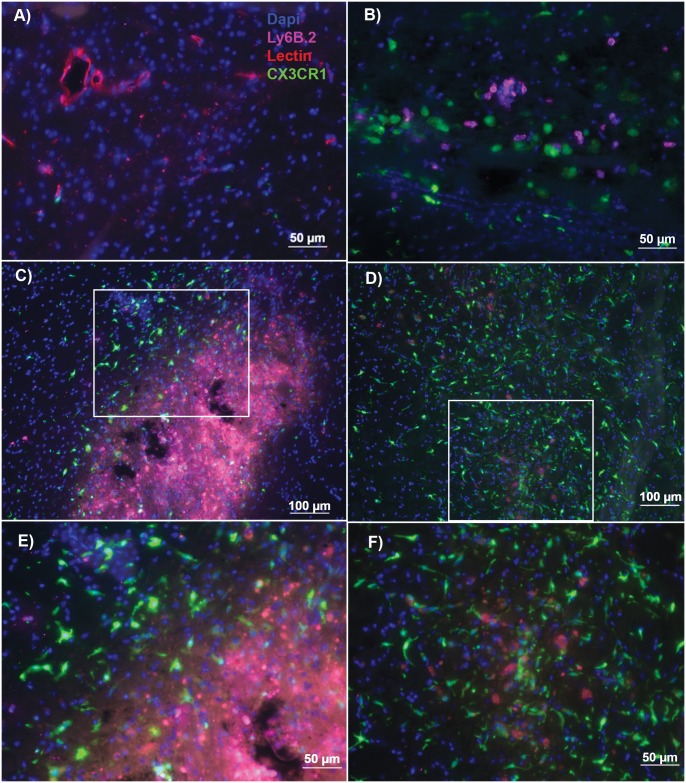
CX3CR1+, Ly6Clo monocytes are present in perihematomal brain in CX3CR1-null BM chimeras.Mice were injected intracardially with 150 ug tomato lectin to delineate vasculature. Brain slices were stained with Ly6B.2 antibody to differentiate Ly6Chi monocytes and neutrophils from Ly6Clo CX3CR1+ monocytes and Dapi nuclear stain. A) Intracardiac injection of lectin stains vasculature in the brain– 20x. B) At 72 hours after ICH, distinct subsets of amoeboid Ly6B.2+ (Ly6Chi monocytes or neutrophils) and GFP+ (CX3CR1+) monocytes are seen in the perihematomal region. 20x. C) At 7 days after ICH, amoeboid, Ly6B.2−,CX3CR1+ cells are seen in the brain parenchyma surrounding the ICH cavity. The center of the ICH cavity is filled with Ly6B.2+ (Ly6Chi) monocytes or neutrophils. Tomato lectin staining is also seen in the center of the ICH cavity, most likely due to blood brain barrier breakdown at this time point leading to nonspecific lectin staining of myeloid cells. 10x. White box indicates the inset shown in panel E. D) At 14 days, amoeboid, CX3CR1+ cells can still be seen in the perihematomal region, however more CX3CR1+ cells have a ramified morphology. No Ly6B.2+ (Ly6Chi monocytes or neutrophils) cells are found. Overall blood-brain barrier disruption is improved leading to less lectin staining in the cavity, although there remain some lectin+ cells (CX3CR1+ monocytes and CX3CR1− microglia). 10x. White box indicates inset shown in panel F. E) 20x image of panel C – perihematomal region 7 days after ICH F) 20x image of panel D – perihematomal region 14 days after ICH. Blue – Dapi, GFP – CX3CR1, Red – Tomato lectin, Pink – Ly6B.2, n = 5.